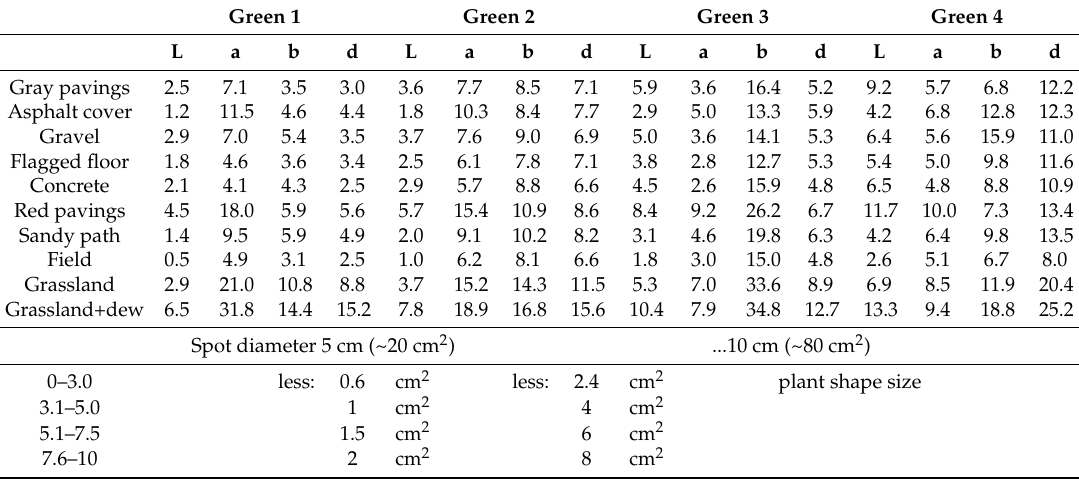
Table 4. Required relative coverage of different shades of green on backgrounds for Channels L, a, b and Virtual Channel